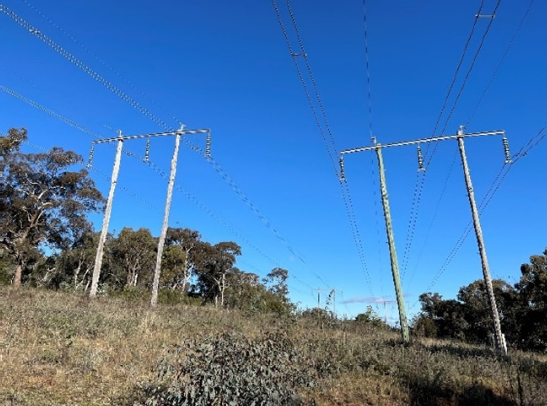
Figure 6. The powerline in bushland on Mount Ainslie in Canberra is an example of the integration of GI with other infrastructures. Photo: F. Mofrad, 2022. of GI with other infrastructures. Photo: F. Mofrad, 2022.